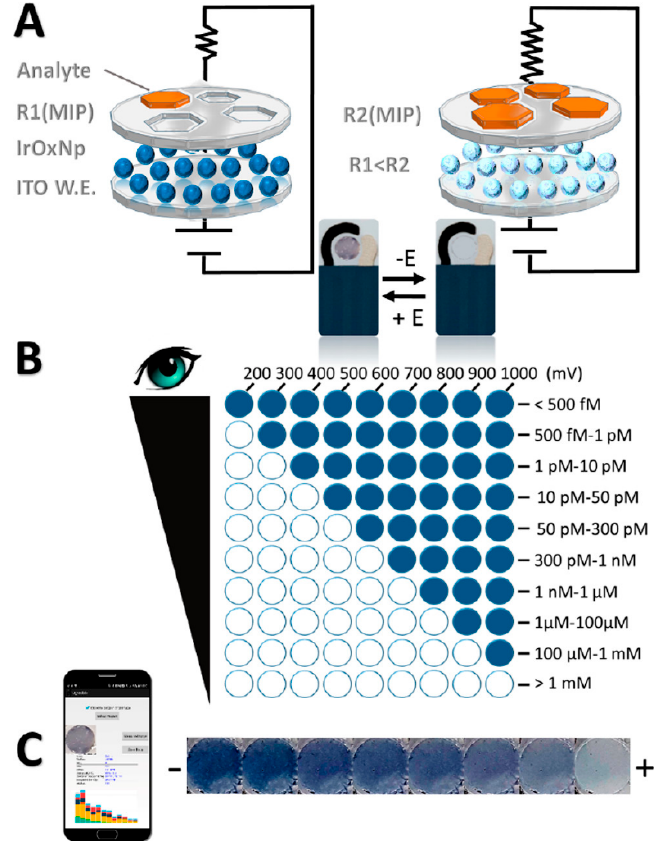
Figure 5. ( A ) Scheme of the MIP/IrOx NPs–ITO screen printed electrodes structure, visual IrOx NPs colour change (from blue-black to colourless) and working principle of the proposed sensor with different amounts of chlorpyrifos. ( B ) Visual detection after 10 s applying different oxidation potentials and concentration ranges detected based on the number of coloured electrodes; ( C ) change of IrOx NPs colour intensity at a fixed time and potential vs. increasing amounts of the analyte (smartphone-based detection). Reproduced from Reference [98] with permission of American Chemical Society. Table 3. Optical sensors based on MIPs deposited on the surface of an electrode.